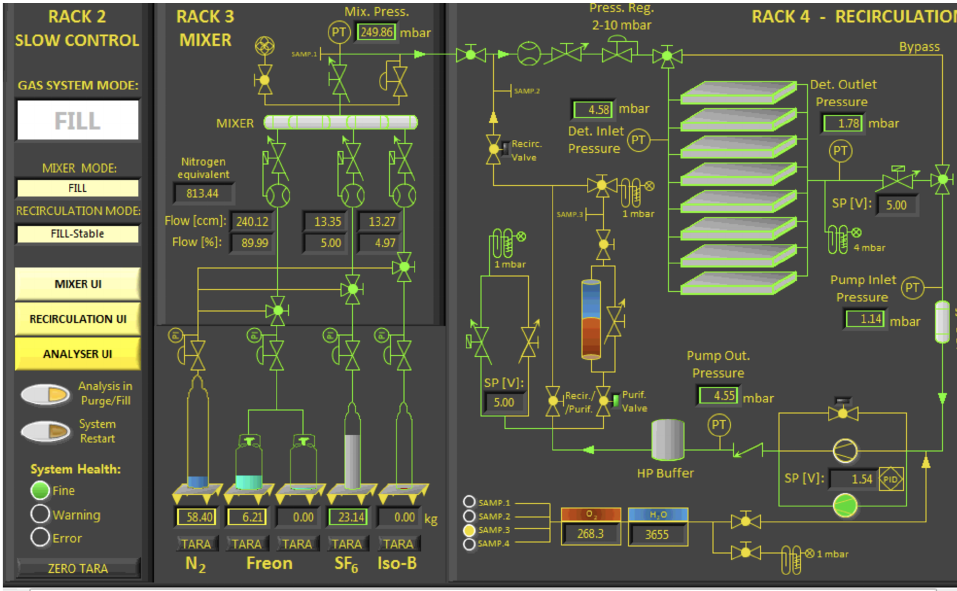
Figure 8. The existing gas system operators screen—the pilot version.